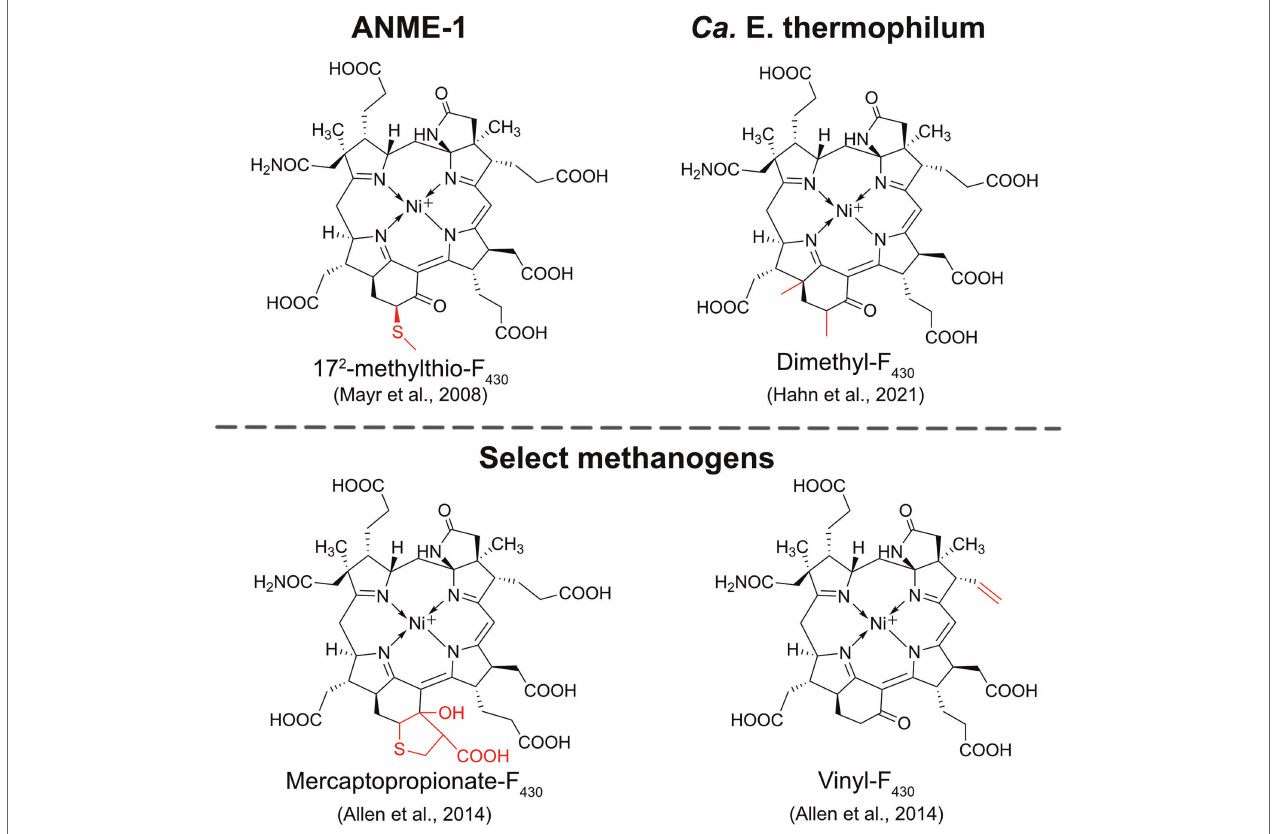
FIGURE 4 | Structures of modified F 430 s. The structures of the modified F 430 s in ANME-1 and Ca. E. thermophilum are confirmed based on NMR and/or crystal structures while the modifications in select methanogens are proposed based on mass spectrometry